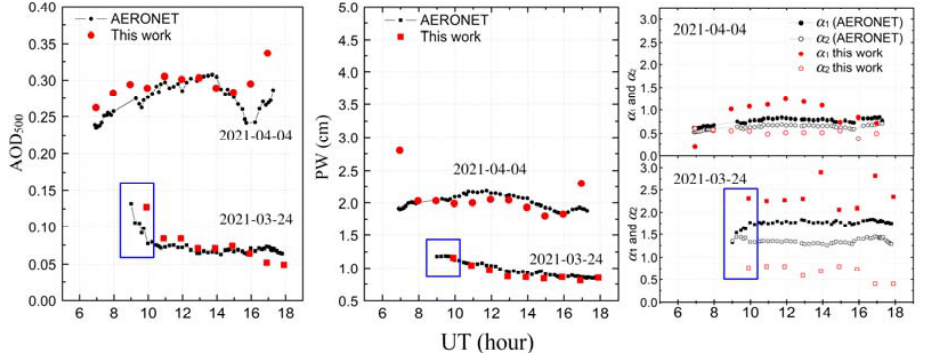
Figure 12. Retrieval of atmospheric constituents (AOD 500 , PW, α 1 , and α 2 ) and their diurnal variation for the two test days of Figure 5. The blue rectangles denote instants when a thin cloud was occulting the sun, as shown in Figure 7. This circumstance induces an arti fi cial increase in the retrieved AOD 500 at Huelva, while no such cloudiness was simultaneously present at El Arenosillo.